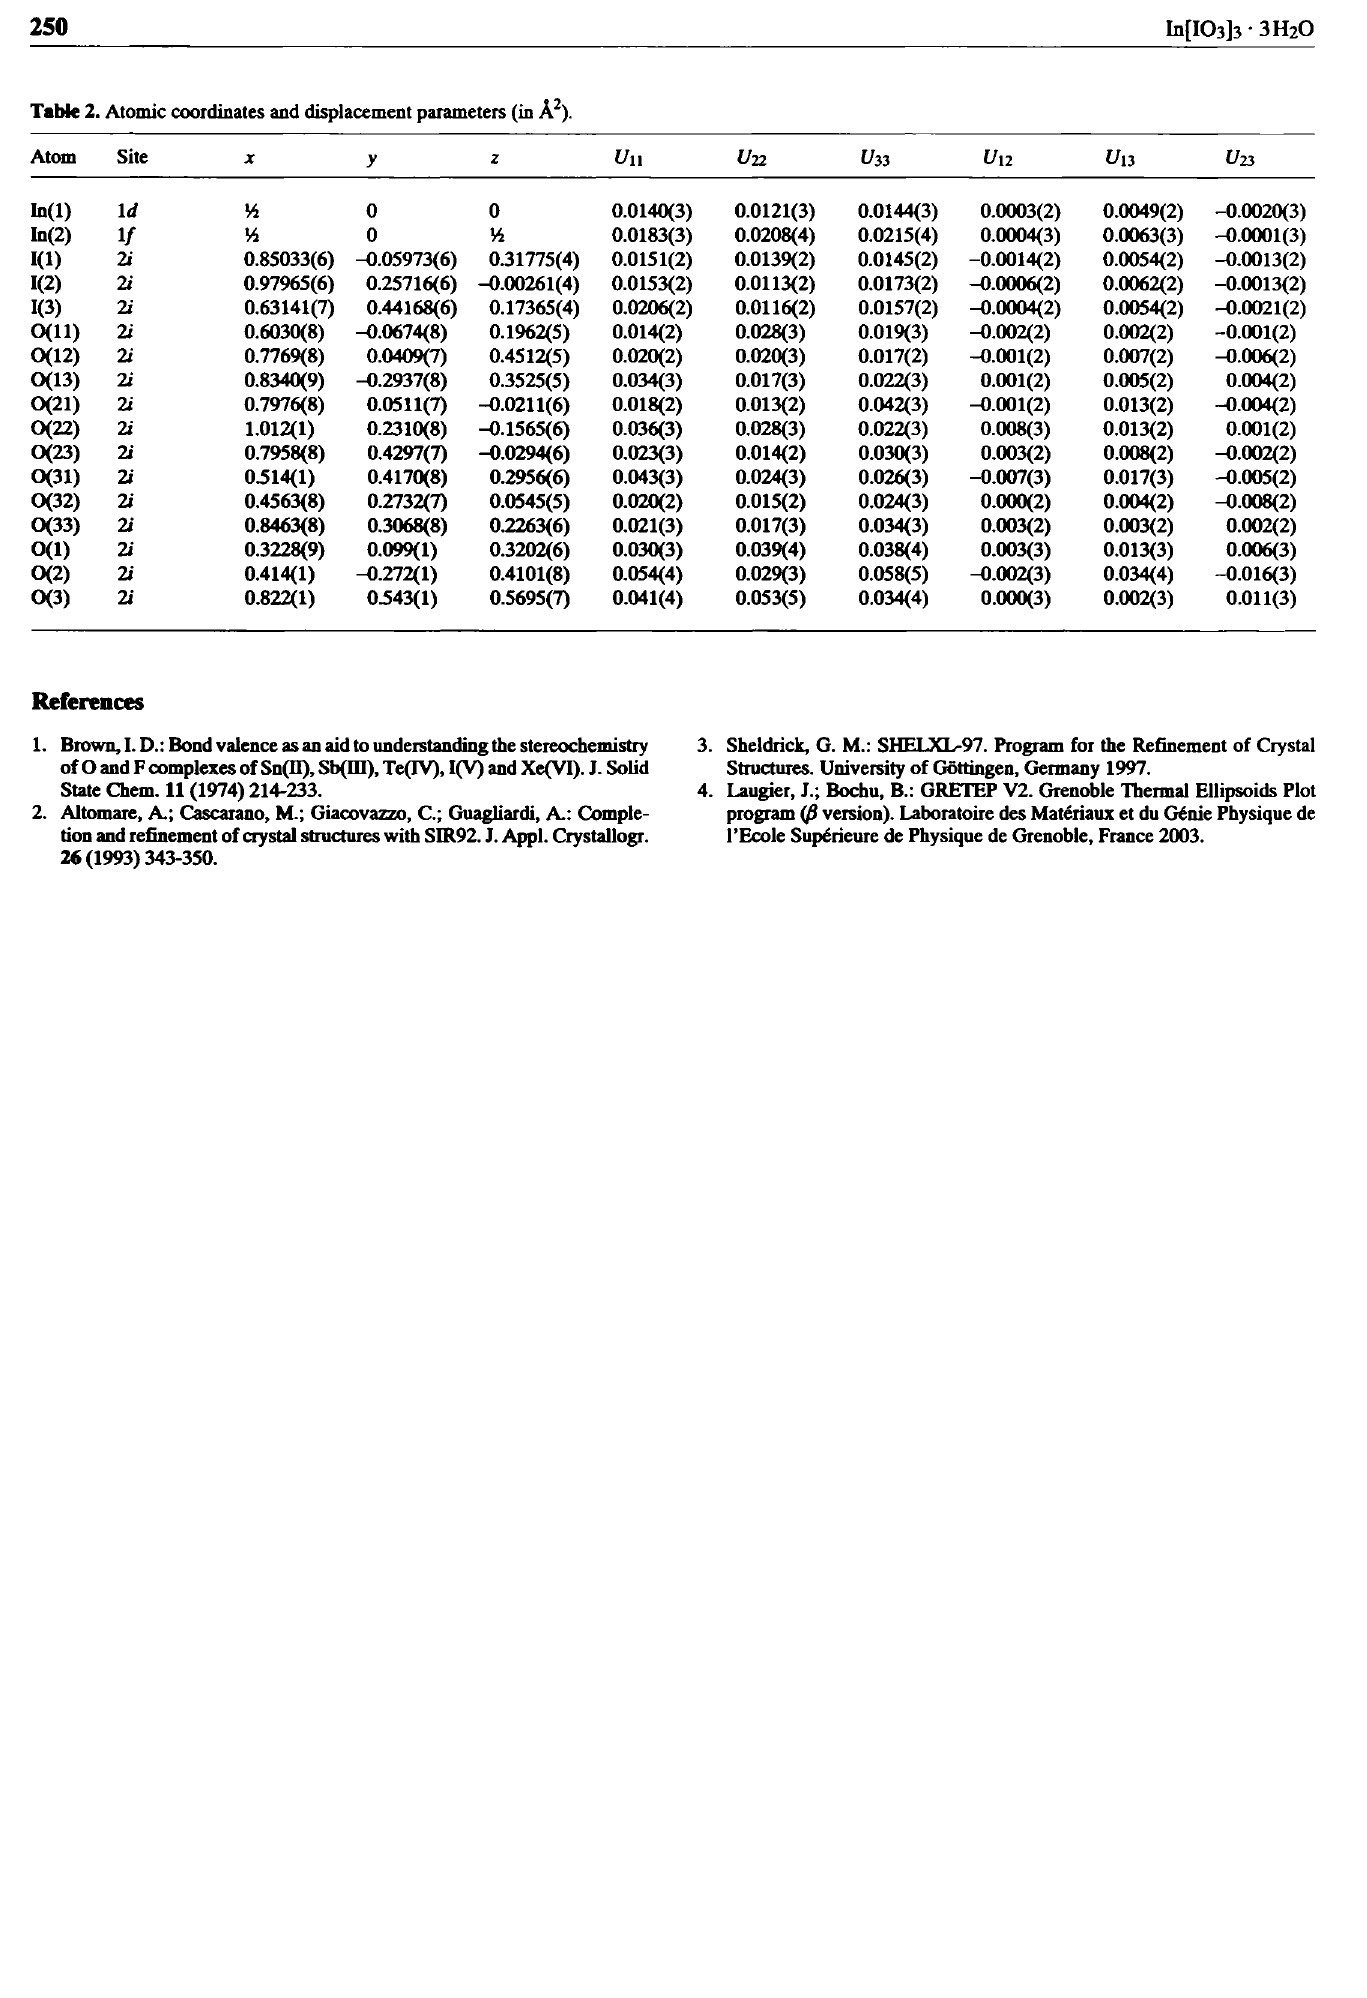
Table 2. Atomic coordinates and displacement parameters (in A 2